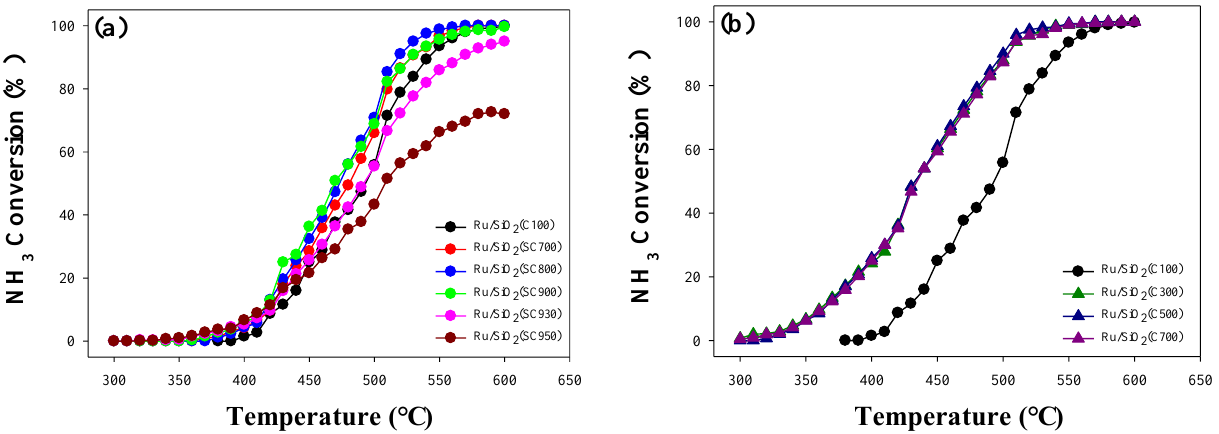
Figure 3. Ammonia conversion for ammonia decomposition over Ru/SiO 2 catalysts. ( a ) Ru/SiO 2 (C100) (black), Ru/SiO 2 (SC700) (red), Ru/SiO 2 (SC800) (blue), Ru/SiO 2 (SC900) (green), Ru/SiO 2 (SC930) (pink), and Ru/SiO 2 (SC950) (brown). ( b ) Ru/SiO 2 (C100) (black), Ru/SiO 2 (C300) (dark green), Ru/SiO 2 (C500) (dark blue), and Ru/SiO 2 (C700) (dark pink). Reaction conditions: feed composition (25 mol% NH 3 , 70 mol% He, and 5 mol% CH 4 ), WHSV = 60,000 mL g cat . −1 h −1 .